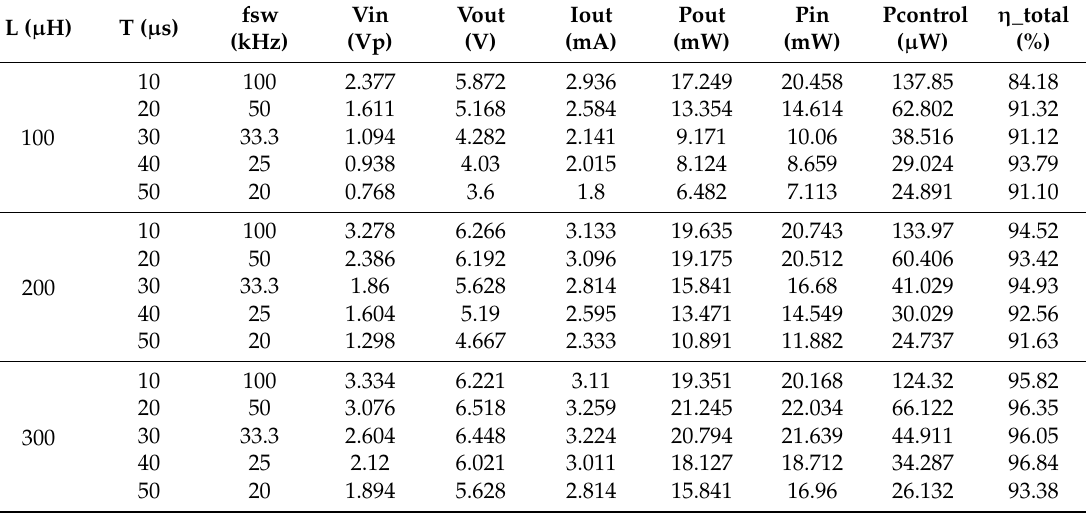
Table 8. Comparative results between different coils and frequencies at 0.1 sun and 5 ◦